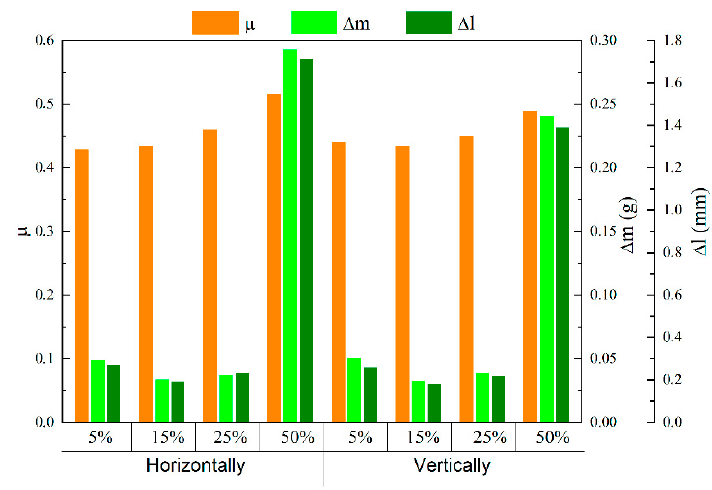
Figure 8. Wear characteristics of multimaterial samples after dry sliding friction tests.